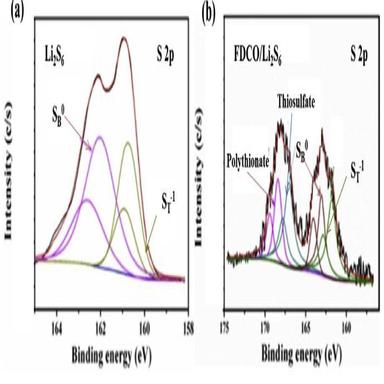
High resolution S 2p XPS spectra of (a) pristine Li2S6 and (b) FDCO/Li2S6 mixture.